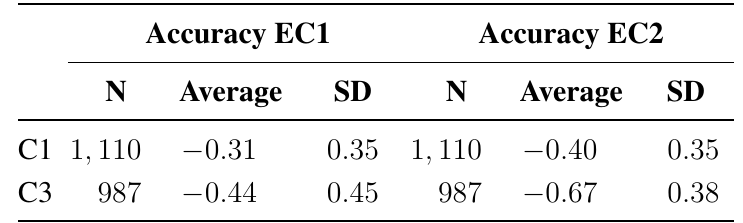
Table 7. Accuracy of tested conductimeters during on-line milking parlour experiment.